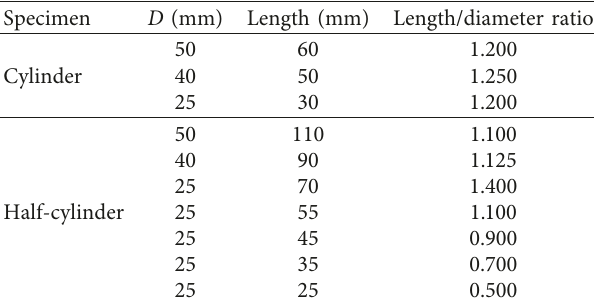
Figure 10: Results of the failure load with the distance D . Table 4: Size parameters of the laboratory